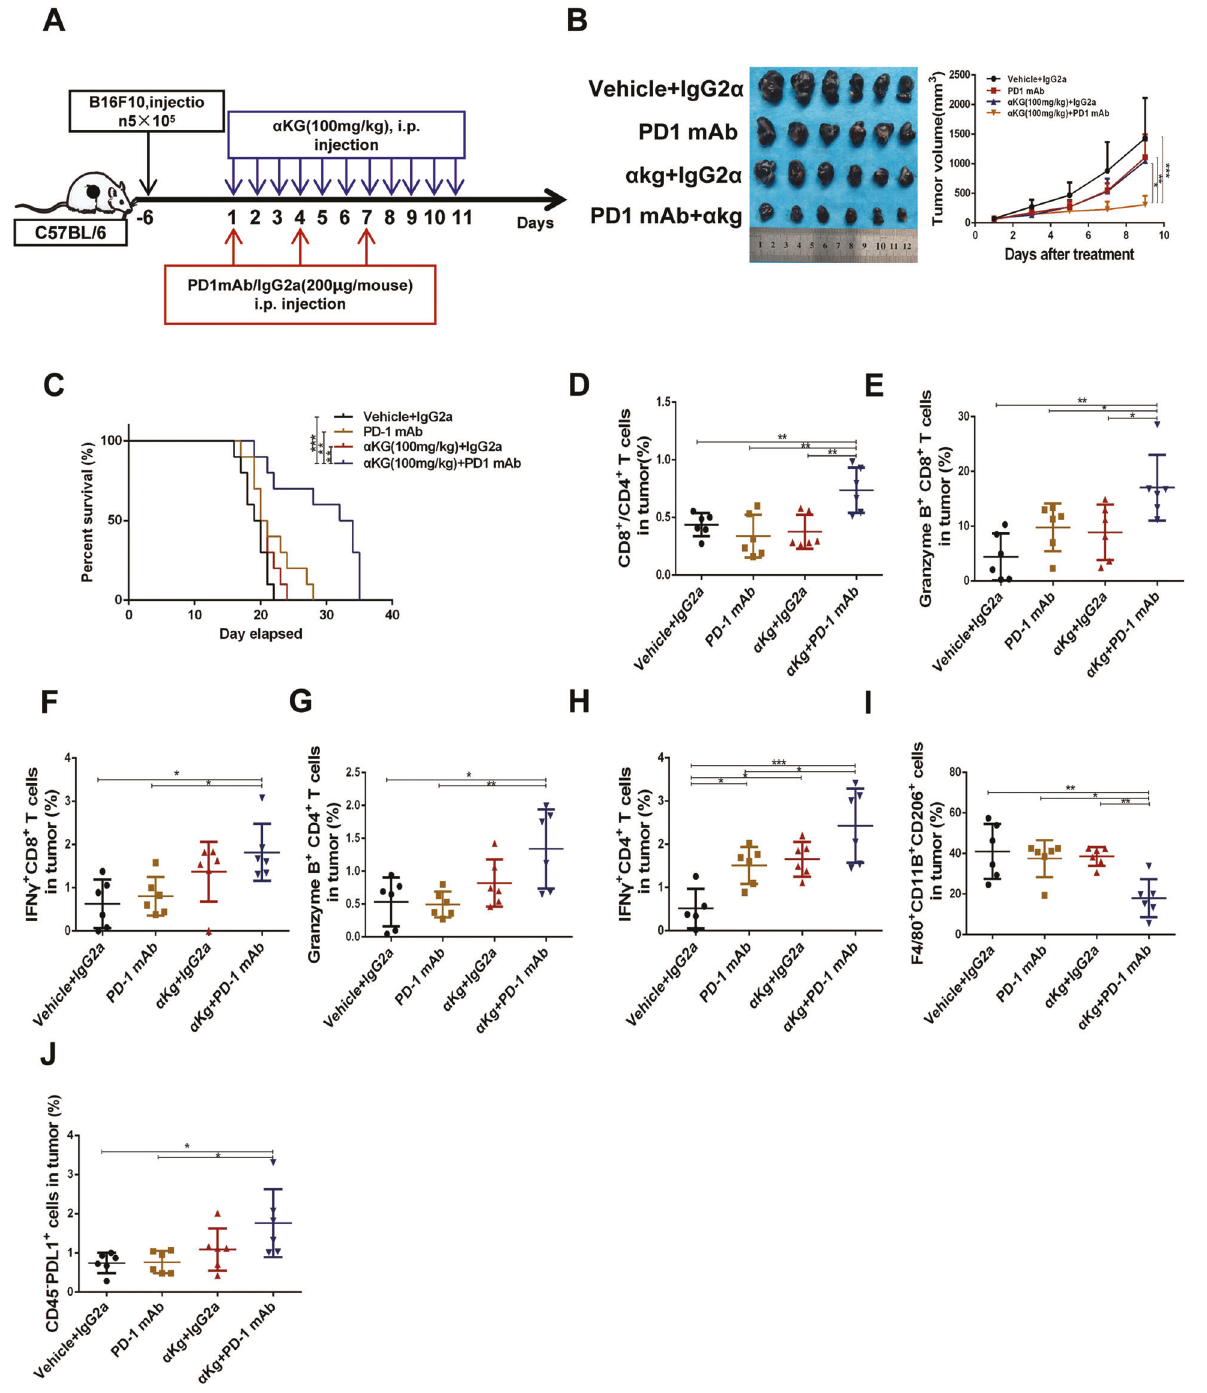
Fig. 1 Supplementation with α -ketoglutarate treatment enhanced the ef fi cacy of PD-1 blockade in B16F10 tumor-bearing mice. A Schematic diagram of α -ketoglutarate combined with PD1 mAb for melanoma treatment. B Tumors isolated from B16F10 tumor-bearing mice receiving the designated treatments (left panel). Tumor growth curves for B16F10 tumor-bearing mice receiving the designated treatments (right panel). C Survival curves of B16F10 tumor-bearing C57BL/6 mice. D The percentage of CD3 + CD8 + /CD3 + CD4 + T cells in tumors determined by FACS. E – I The percentage of CD3 + CD8 + Granzyme B + T cells E , CD3 + CD8 + IFN γ + T cells F , CD3 + CD4 + Granzyme B + T cells G , CD3 + CD4 + IFN γ + T cells H , and F4/80 + CD11B + MHC-II + macrophages I in tumors determined by FACS. J The percentage of CD45 - PDL1 + cells in tumors determined by FACS. Multiple experimental data ( n = 6) are counted and presented according to the statistical methods, and an asterisk (*) indicates the degree of signi fi cant